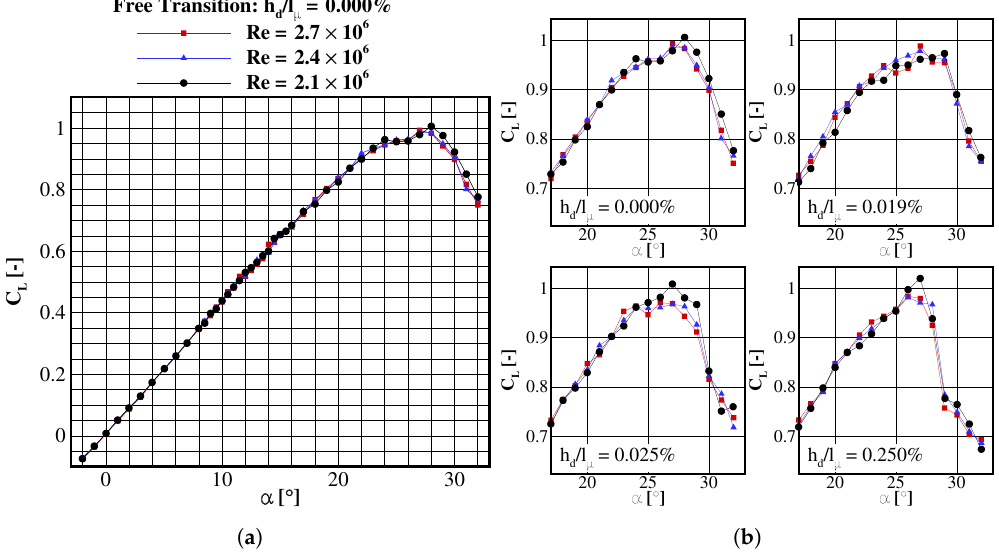
Figure 7. Lift coefficient as function of angle of attack and Reynolds number. ( a ) Free Transition; ( b ) Detail view at post-stall for different disturbance